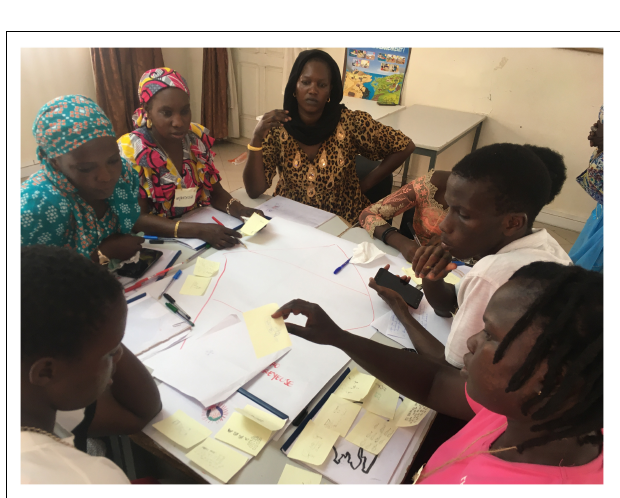
FIGURE 1 | Change journey canvas for individual or collective one-year action plans (adapted from Mayoux and Oxfam-Novib,